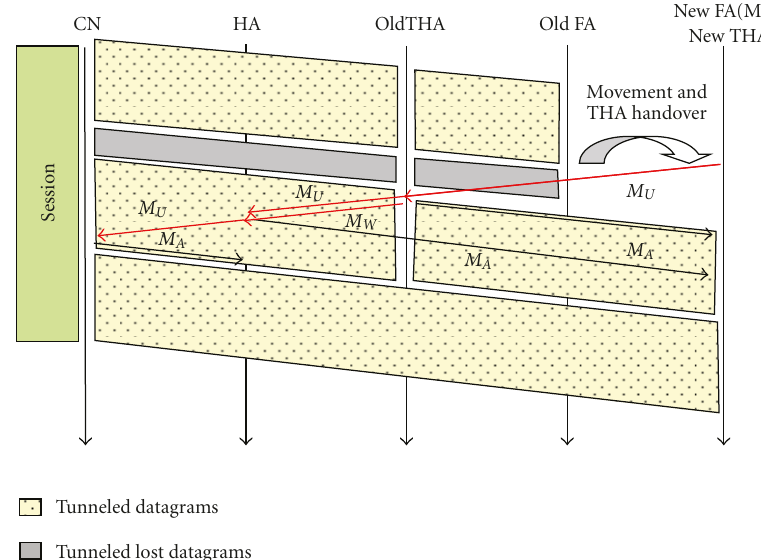
Figure 3: Flow diagram for THA handover.